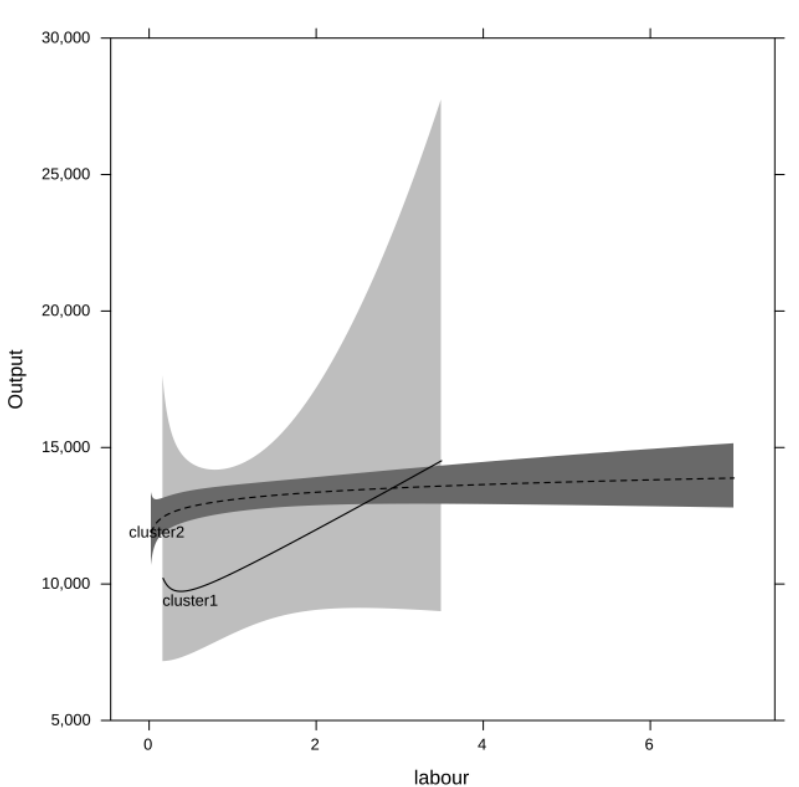
Figure 2. Capital effects by cluster.